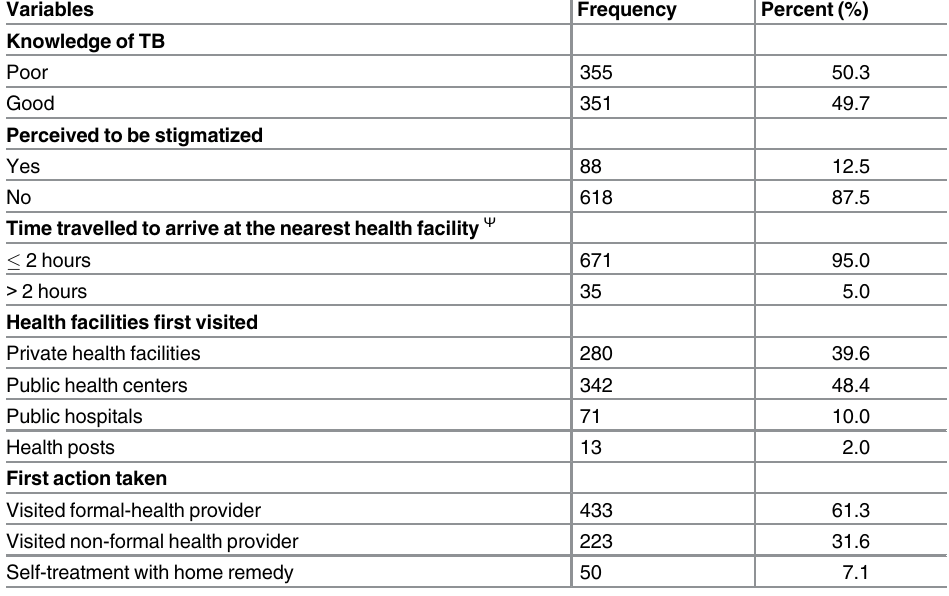
Table 2. Knowledge about TB and health seeking of the study participants, October 2013 to May 2015, West Gojjam Zone, Ethiopia.